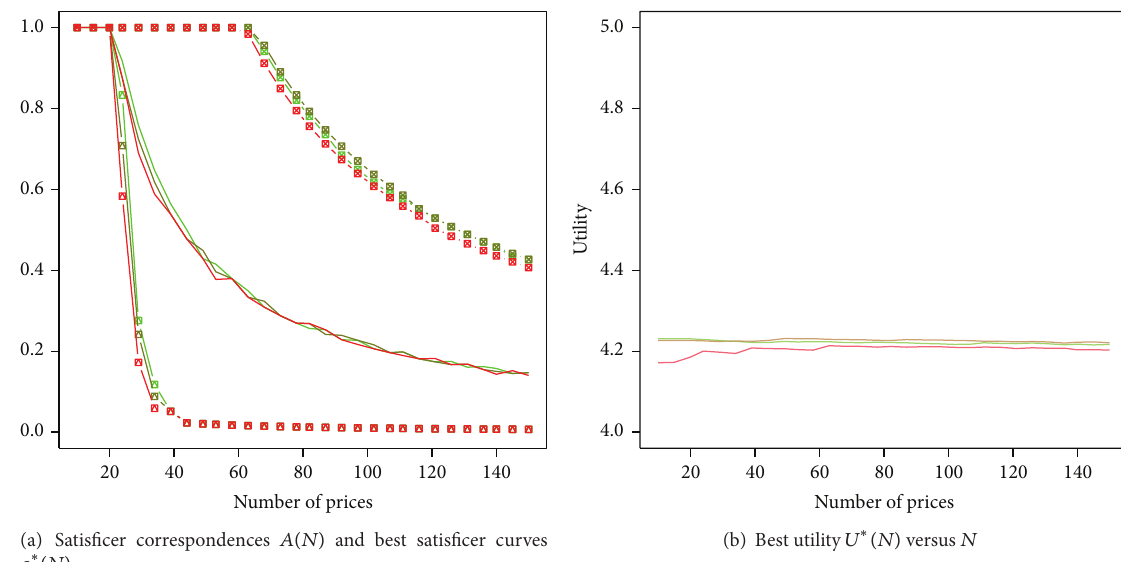
Figure 6: Satisficing behavior and induced optimal welfare for a set of distributions with different shapes preserving mean and dispersion (see Table